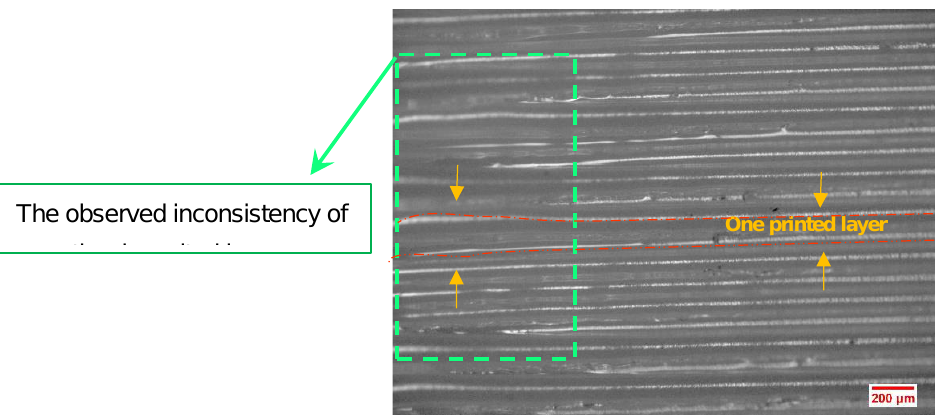
Figure 9. Optical microscopy of the printed PA6 specimen under a bed temperature value of 80 °C.